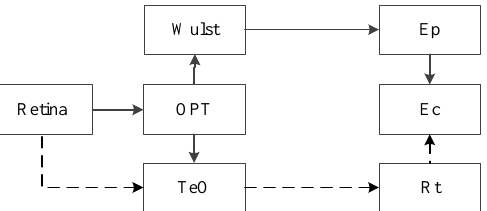
Figure 7. The sketch of the optic tectum pathway (dotted line) and thalamic pathway (solid line) in a raptor’s brain [36].